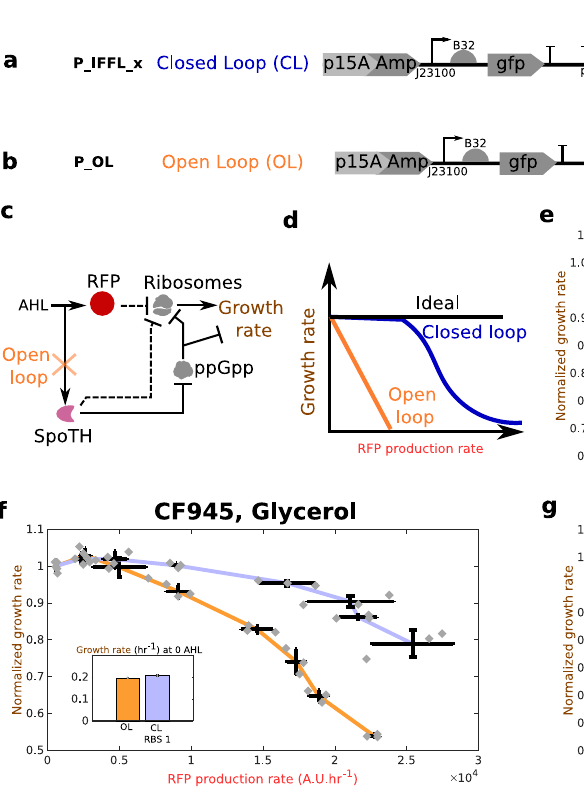
Fig. 3 | Feedforward ribosome controller compensates for burden caused by a GOI (RFP) activation at different nominal growth rates. a CL system ’ s genetic construct (P_IFFL_x) co-expresses RFP and SpoTH via the AHL inducible Plux pro- moter.TheSpoTHRBSisusedasatuningparameter(Supplementarynote5). b OL system ’ s genetic construct (P_OL) expresses RFP using the AHL inducible Plux promoter. c Circuit diagram illustrating how AHL induction affects ribosomes and growth rate for the open loop (OL) or closed loop (CL) systems. In the OL system, SpoTHisnotpresent,sothereisonlytheupperpathfromAHLtoribosomes.Inthe CL system, AHL also activates SpoTH expression and hence upregulates ribosome concentration and growth rate. Dashed edges represent sequestration of free ribosomes by a protein ’ s expression. d Expected growth rate as the RFP gene is activated for the ideal case, the OL, and the CL systems. e – g Growth rate